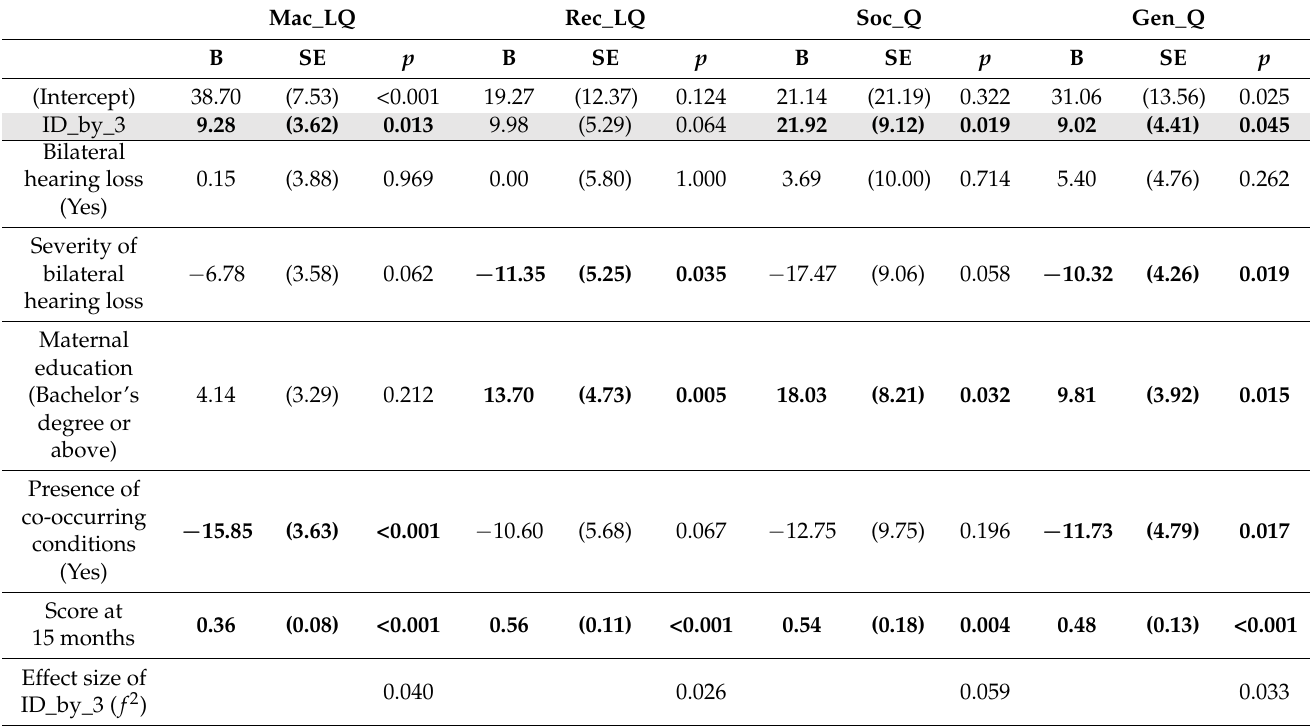
Table 5. Transition regression analysis result of multiple factors on selected developmental